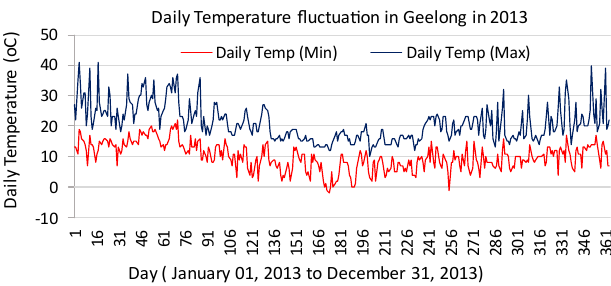
Fig. 1. Daily temperature fl uctuation in Geelong